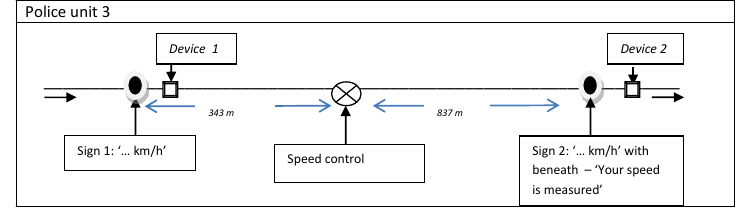
Figure 1. Field set-up for each regional police unit.